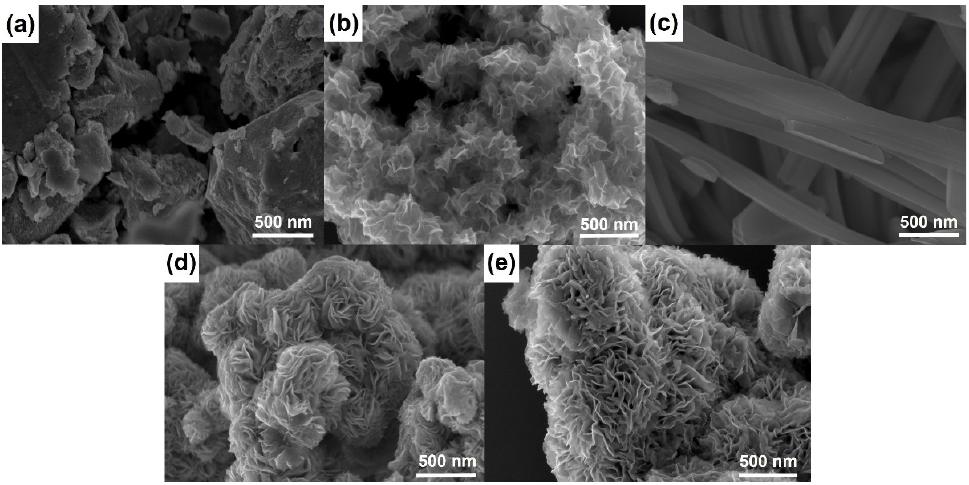
Figure 2. SEM images of WS 2 -bulk ( a ), WS 2 -OX ( b ), WS 2 -OX-PEG ( c ), WS 2 -OX-PVP ( d ), and WS 2 - OX-CTAB ( e ) showing the different morphologies of WS 2 in the samples after heat treatment. Figure 3 shows the performance of WS 2 as cathodes in magnesium batteries at 500 mA/g in different electrolytes. In cells using an APC electrolyte, discharging capacities for all cathode types (WS 2 -bulk, WS 2 -OX, WS 2 -OX-PEG, WS 2 -OX-PVP, and WS 2 -OX-CTAB) declined sharply with the cycle number. Capacities achieved in the first full cycle are 10.4, 24.3, 98.5, 126.1, and 125.2 mAh/g, respectively (Table S3). For the final cycle, the capacities are 0.7, 3.5, 47.2, 64, and 55.1 mAh/g, respectively. In cells using DMM electrolytes, the discharge capacities showed a little decline over cycles. The trend indicates that coulombic efficiencies reached almost 100% showing very good reversibility. The highest capacities achieved for WS 2 -bulk, WS 2 -OX, WS 2 -OX-PEG, WS 2 -OX-PVP, and WS 2 -OX-CTAB are 6.4, 24.9, 133.5, 146.4, and 144.3 mAh/g, respectively (Table S3). These capacities remained stable over the first 100 cycles at a very high current density of 500 mA/g. For the final cycle, the capacities are 5.9, 23.7, 127.8, 142.7, and 137.6 mAh/g, respectively. It was observed that the battery performance was improved by using DMM instead of APC as the electrolyte. The retained charge capacities in cells using DMM electrolyte after 100 cycles are notably higher than those in APC cells after a few initial cycles. Moreover, the WS 2 -bulk and WS 2 -OX samples show very low specific capacity, indicating the electrochemical inactivity of these samples. These results might be explained by the small specific surface area of the WS 2 -bulk (10 m 2 /g) and WS 2 -OX (28 m 2 /g) samples. In contrast, the nanoflower morphology of WS 2 -OX-PVP and WS 2 -OX-CTAB samples resulted in a high specific area with 80 m 2 /g and 70 m 2 /g, respectively; thus, they show the best electrochemical performance. Although the WS 2 -OX-PEG sample shows a different morphology (i.e., nanorods), it still exhibits an average surface area of 57 m 2 /g and a reasonably good electrochemical performance. Although the WS 2 -OX sample exhibit similar morphology to that of WS 2 -OX-PVP and WS 2 -OX-CTAB, it shows a much lower electrochemical capacity than the latter two samples due to its low specific surface area (28 m 2 /g). Similar electrochemical inactivity was reported for MoS 2 /C cathodes due to the reduction in the specific surface area [19,23]. It is well known that a higher surface area of electrode materials in batteries could increase the contact area with the electrolyte, accessibility to the active sites, and utilization of the electrode capacity, often resulting in a higher specific capacity [39].